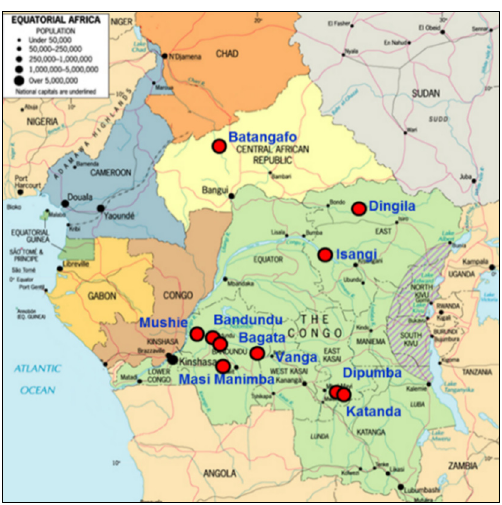
Figure 5. The study sites of the fexinidazole combined phase II/III clinical